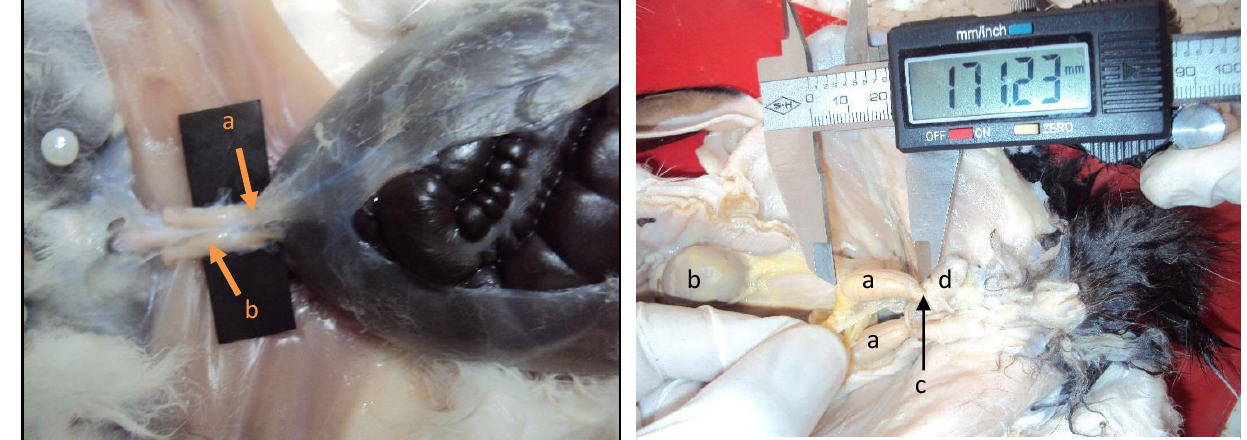
Figure, 8: Shows the shape, size and position of testis in situ in the rabbit at 90- days age a-testis b- kidney c-ligament of the tail of epididymis d- part of inguinal canal.